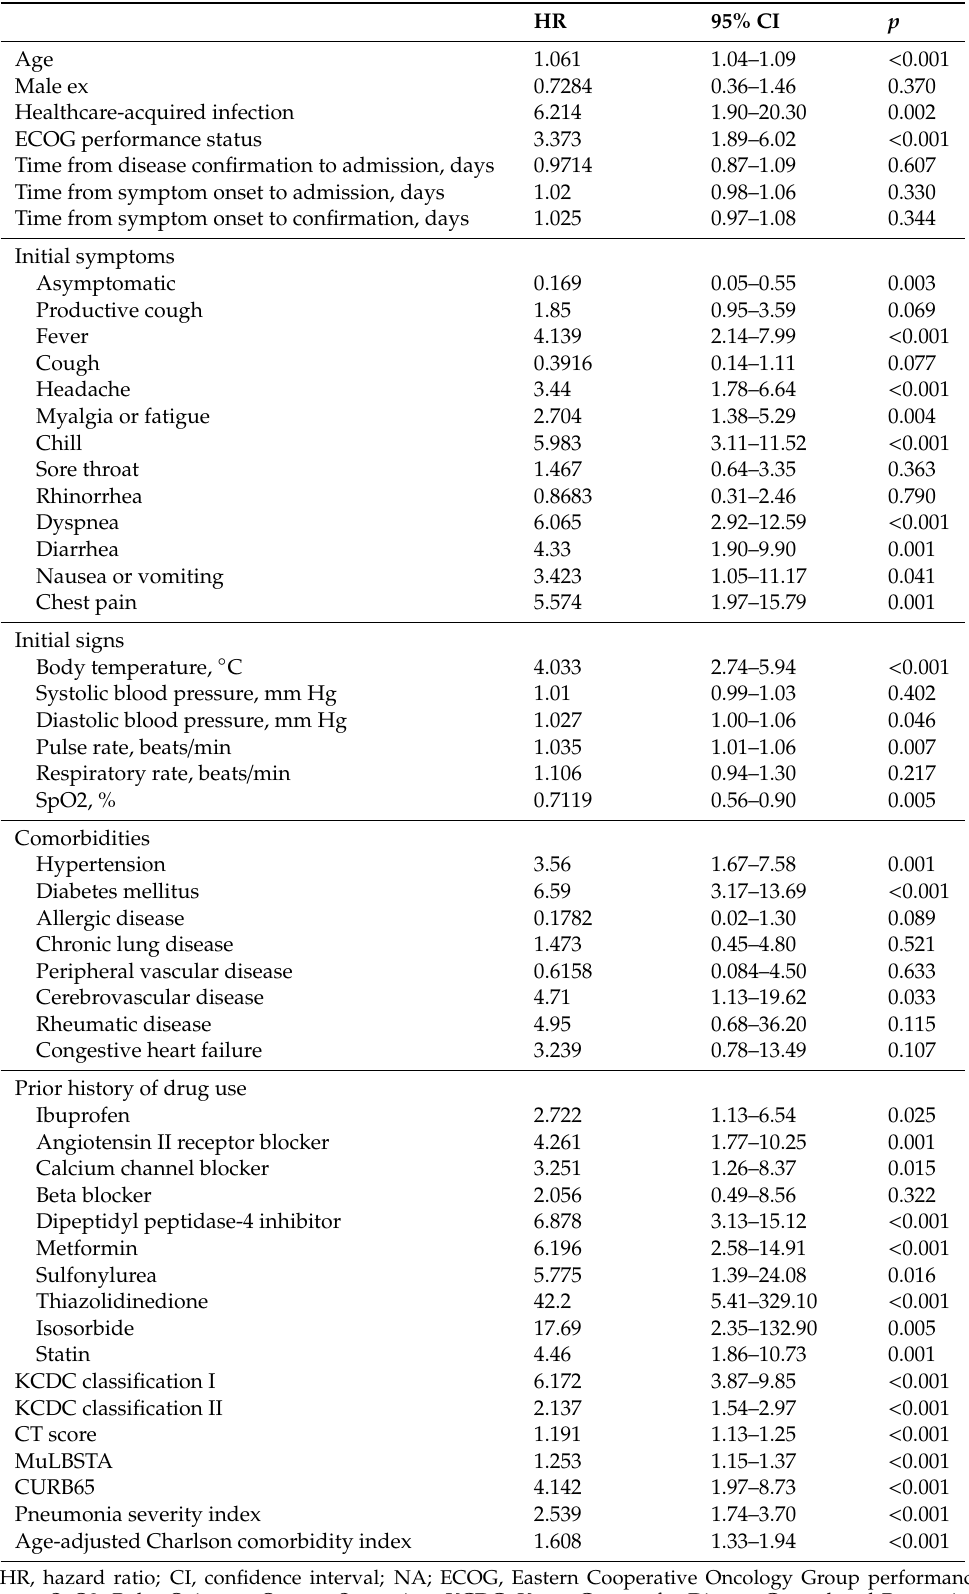
Table A5. Cox regression of risk factors for progression-free survival of COVID-19 patients